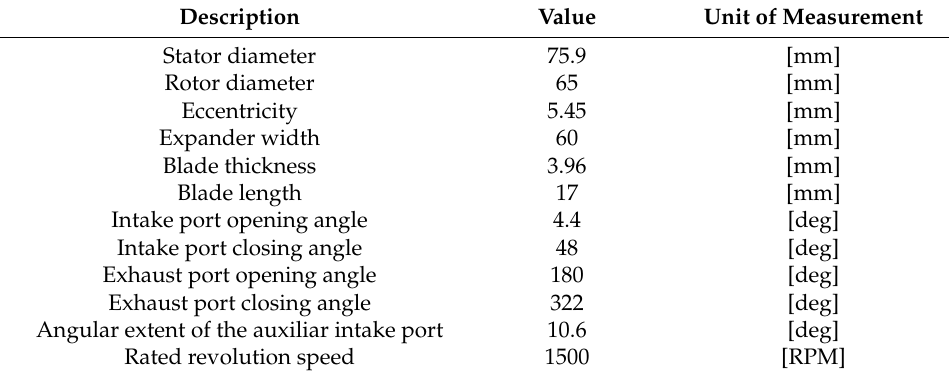
Table 5. SVRE expander geometry and intake and exhaust ports.